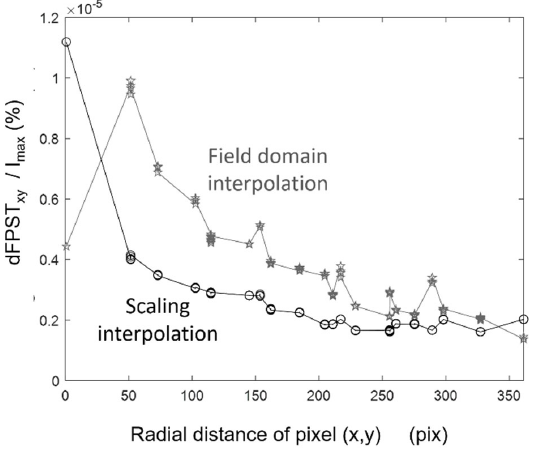
Figure 11. The 2 σ error on FPST x,y as a function of the radial distance of pixel ( x,y ) from the center. The FPST is interpolated either with the scaling method or with the field domain method.